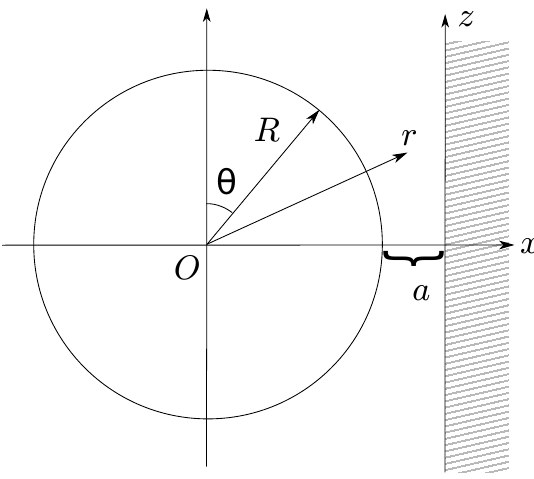
Figure 4 . Setup for computation of the binding energy between two B = 1 Skyrmions using the mirror trick and certain gluing conditions at x = 0 and the B = 1 Skyrmion is placed at x = − R − a . The figure is shown at y = ϕ = 0